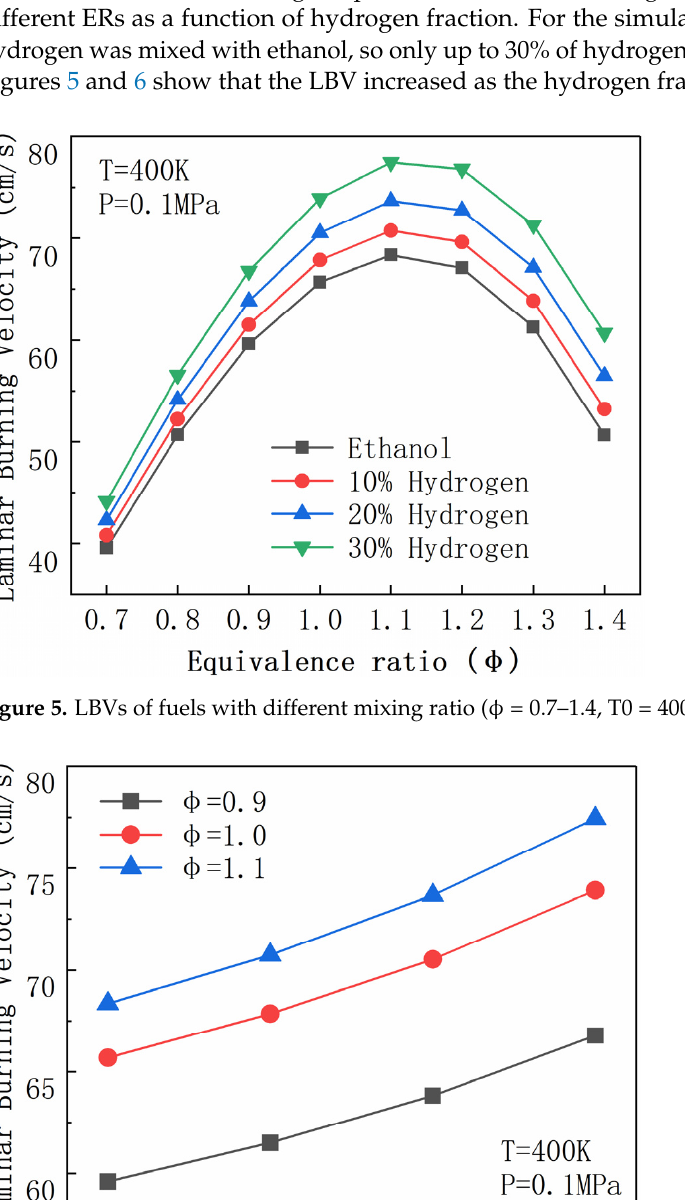
Figure 4. Comparison of LBVs obtained by simulation and experiment: T0 = 400 K and P0 = 0.1 MPa, with a hydrogen composition of 30% and 90%.